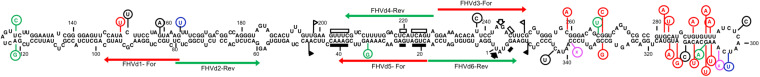
Primary and predicted secondary structures of lowest free energy of the fig hammerhead viroid-like RNA variant A1 (FHVd-LR_A1) collected from the island of Oahu. Regions involved in the formation of (+) and (−) hammerhead structures are delimited by flags; arrows and bars indicate the self-cleavage sites and the nucleotides conserved in most natural hammerhead structures, respectively; filled (black) and open symbols refer to (+) and (−) polarity, respectively. Mutated positions in other FHVd-LR variants are indicated in circles, with compensatory mutations, insertions, and deletions reported in green, blue, and pink, respectively. Nucleotide changes with respect to the short VL-RNA from the island of Kauai are in red. Horizontal arrows delimit the regions targeted by primer pairs used in the amplification steps of the cloning and sequencing strategy.